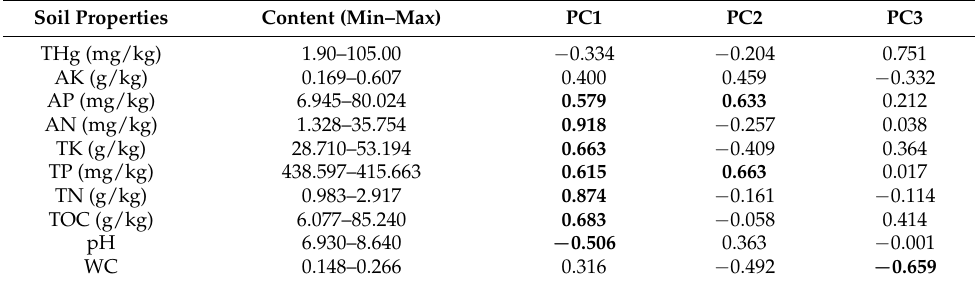
Table 2. Concentration range of soil variables, factor loadings, and explained variance following a principal component analysis (PCA) on the soil variables of samples from Hg mining area. The variables highly associated with particular PCs are indicated in